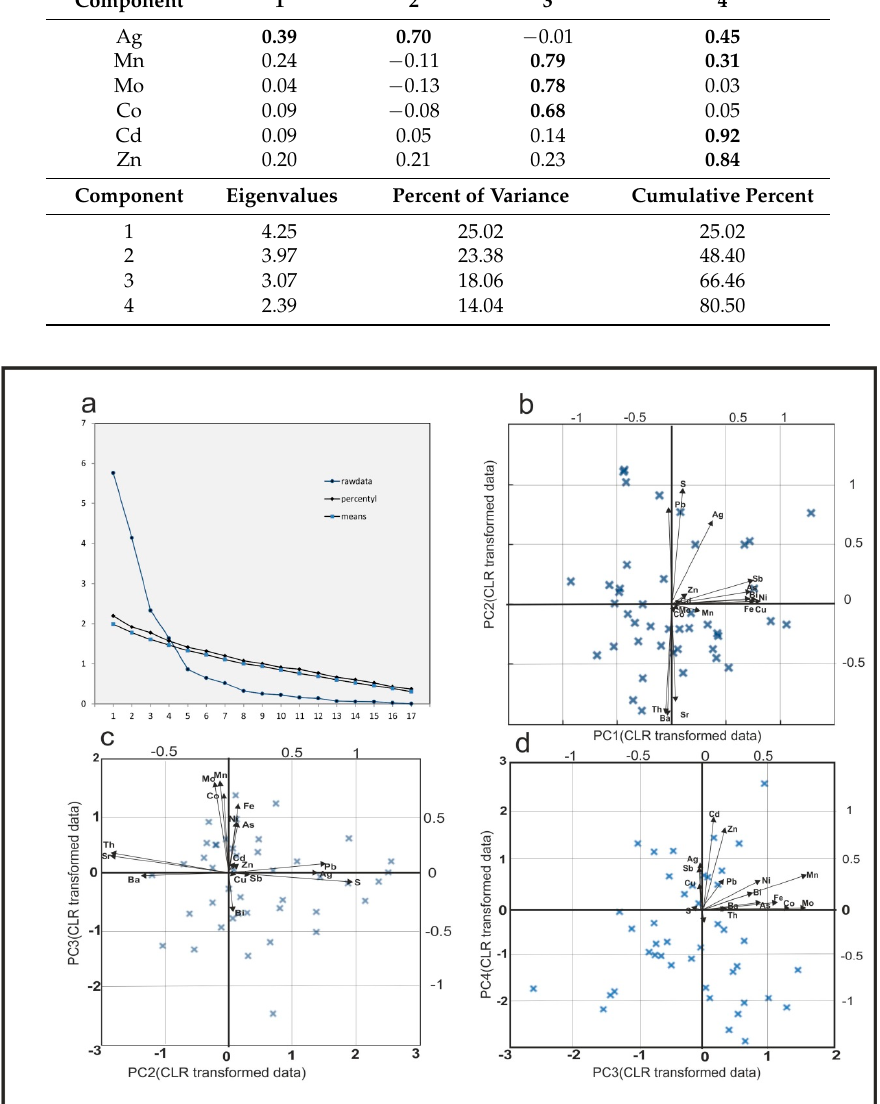
Figure 8. ( a ) Scree plot of eigenvalues (higher than raw data line) using PCA on CLR from the tunnel samples in Block A of the Ravanj deposit; ( b ) Biplot of PC1 vs. PC2; ( c ) Biplot of PC2 vs. PC3; and ( d ) Biplot of PC3 vs. PC4.